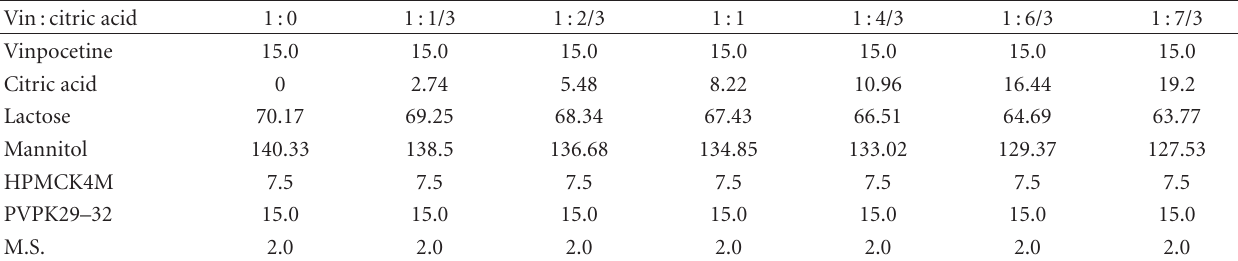
Table 1: Composition for core tablets with various molar ratios of vinpocetine and citric acid (unit:mg).